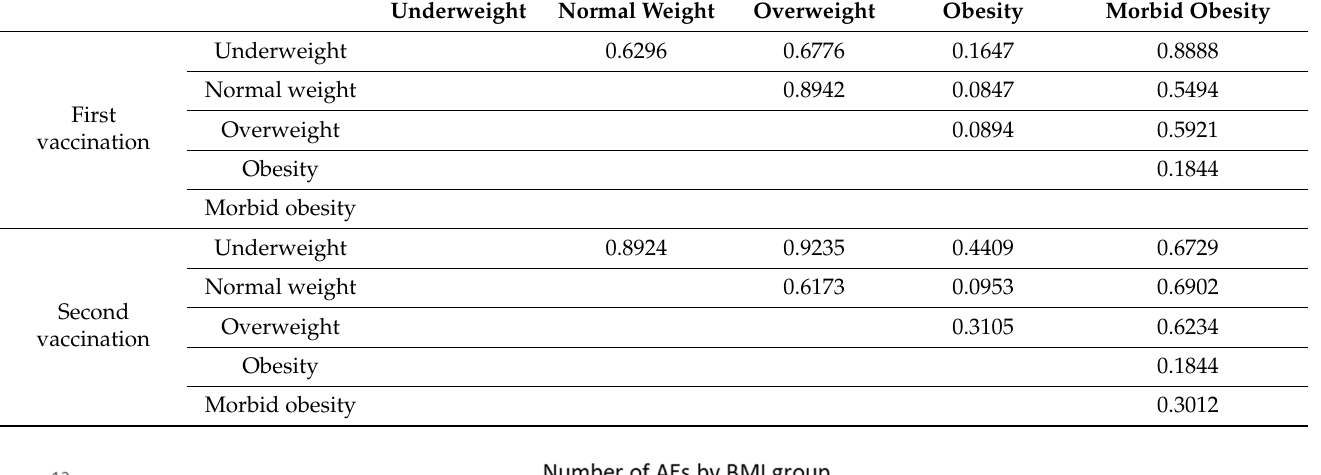
Figure 3. Number of adverse events by gender. □ mean ± standard deviation; ◊ median; │ minimum − maximum. Table 3. Two-sided p -values for difference in adverse events between body mass index (BMI) groups.